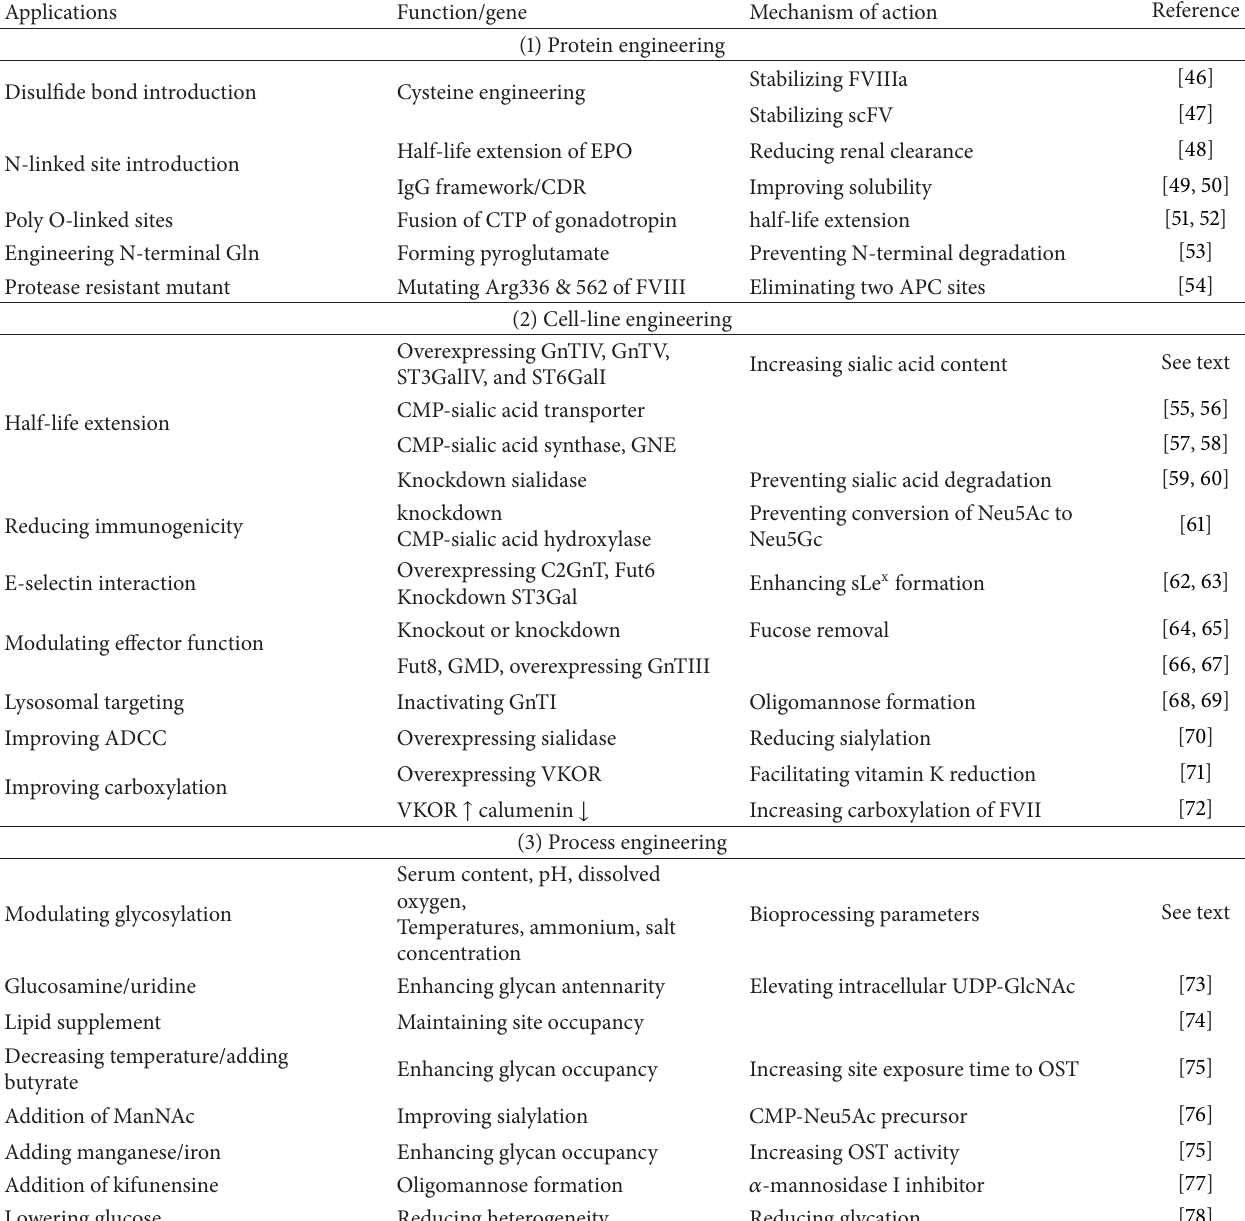
Table 2: Biopharmaceutical applications of therapeutic protein